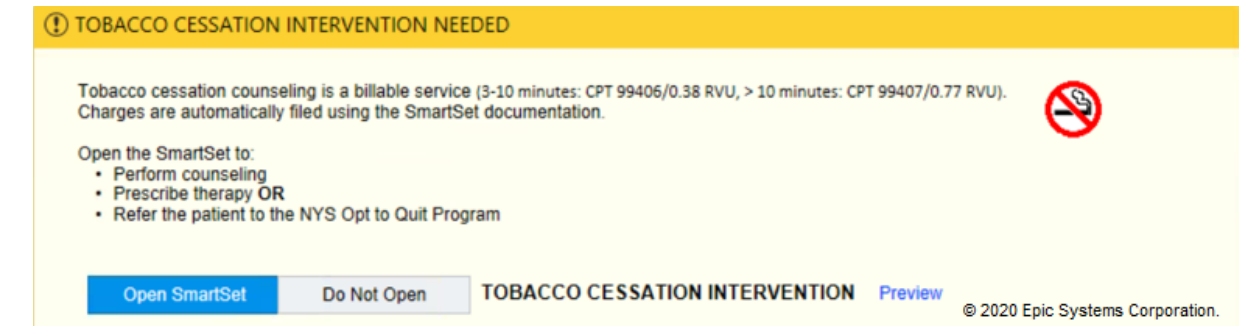
Figure 12. Tobacco financial messaging alert with image of no smoking sign tested in Round 3 of the randomized controlled trial. Copyright 2020, Epic Systems